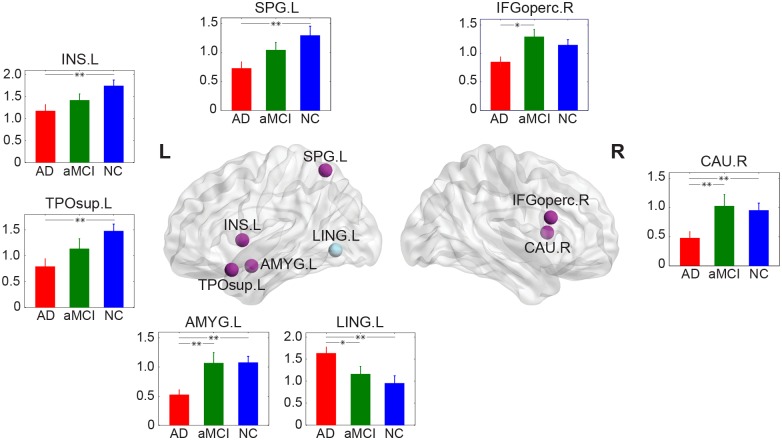
The distribution of brain regions with both significant (p<0.05, uncorrected) groups effects in BC and significant (p<0.05) correlation between BC and MMSE scores.Each bar represents the average BC values for AD (red), aMCI (green), and NC (blue). Error bars represent standard deviations (S.D.). The regions were overlaid on the brain surface at the Medium view. Post hoc pairwise comparison was performed through Fisher’s least significant difference (LSD) with * indicates p<0.05 and ** indicates p<0.01. Regions showing positive correlation are coded in purple and region showing negative correlation is coded in light grey. For the abbreviations of cortical regions, see Table S1. L = left; R = right. The figure was visualized with BrainNet Viewer software (http://www.nitrc.org/projects/bnv/).